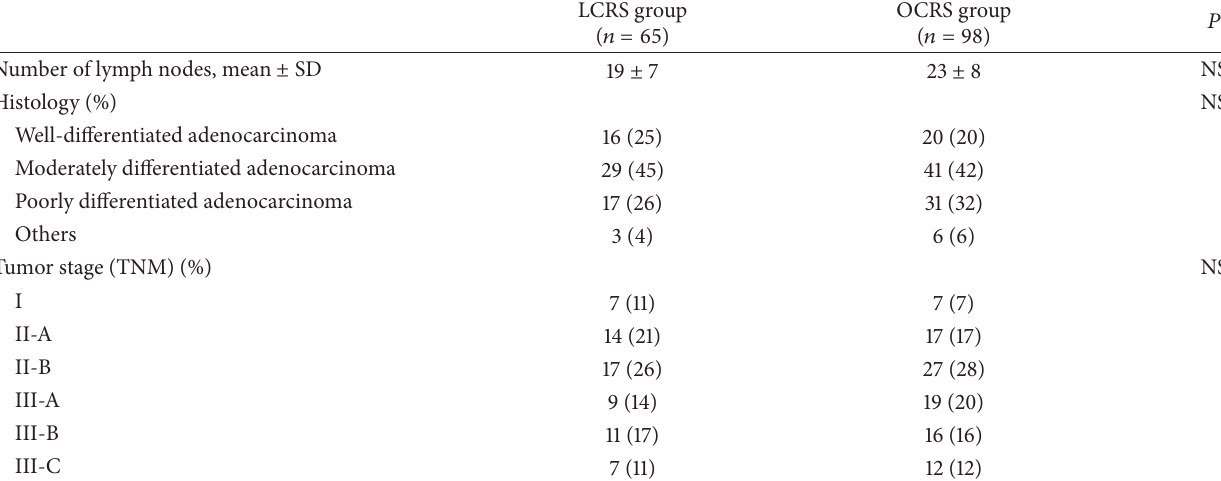
Table 4: Comparison of the pathological parameters in two